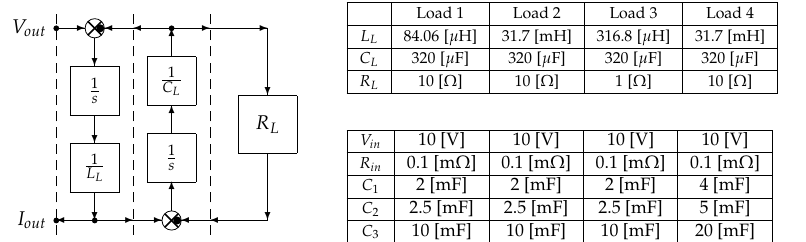
since the length of the blue voltage trajectories in Figure 33 is not constant. On the other hand, the Variable-Step Control is indeed capable of ensuring the convergence of vector V c Figure 30. Non-Deformation of the output voltage waveform in the extended operation of the converter with the Configuration Voltage Vector V m = [ 7 6 2 ] T , in presence of a sudden load change, thanks to the Variable-Step Control.